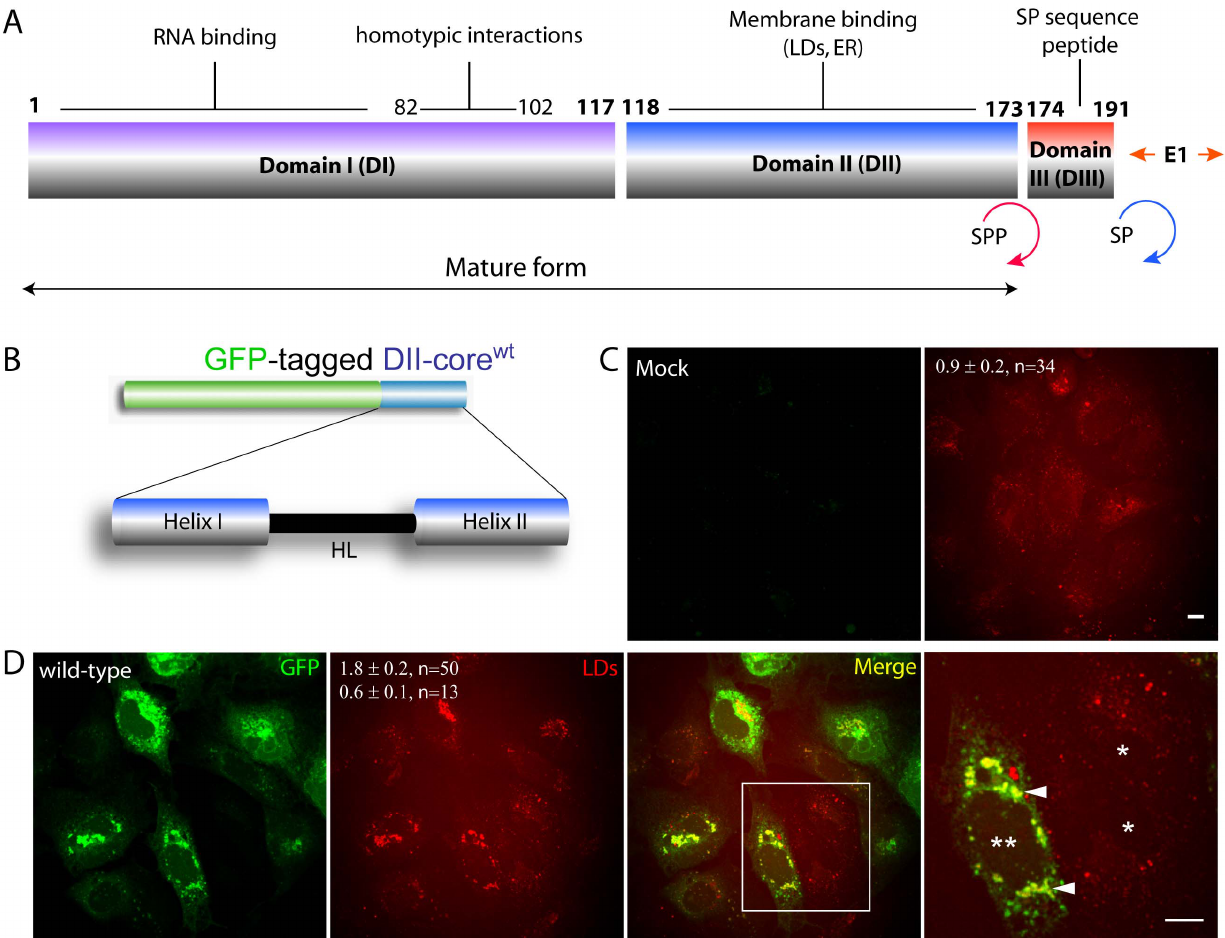
Figure 1. GFP-tagged DII-core wt colocalizes with LDs. (A) Schematic representation of HCV core protein. Distinct interactions belong to each of the three core protein domains. The mature and immature forms are also shown, and are generated by the two host proteases: signal peptidase (SP, blue), and signal peptide peptidase (SPP, red). (B) GFP-tagged DII-core wt contains the membrane binding domain consisting of two a -amphipathic helices separated by a hydrophobic loop. (C-D) CARS microscopy imaging of LDs in Huh-7 cells expressing GFP-tagged DII-core wt . All images were collected approximately 20 hours after Huh-7 cells were transfected with (D) DII-core wt and (C) without DII-core wt , which contained only the lipofectamine transfection reagent. (C) Lipid volumes measured by voxel analysis for mock Huh-7 cells are shown in the CARS image. (D) CARS imaging captures DII-core wt induced LD biogenesis and redistribution towards the perinuclear region. The two values in panel 2 represent the average LD volume for cells expressing DII-core wt (top value, double asterisks) and non-expressing DII-core cells (single asterisks) within the same field of view (bottom value) as measured by voxel analysis. The error represents standard error of the mean. The n represents the amount of cells quantified for LD density. This experiment was conducted under two biological replicates. Panel 4 is a magnified image selected by a region